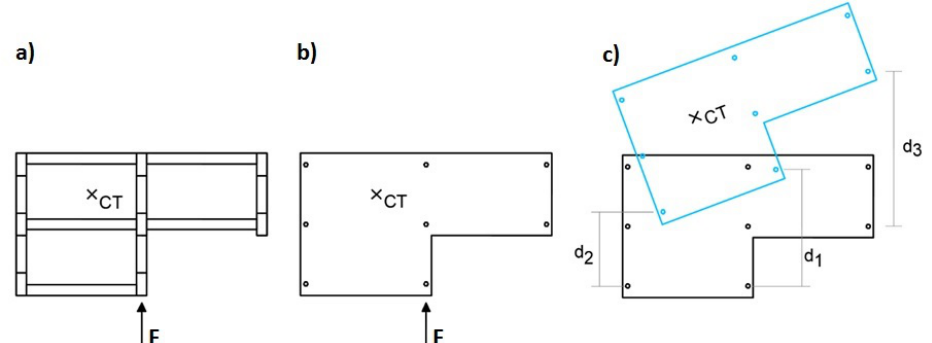
Figure 4. a) Force F at a building`s floor with center of twist CT. b) Simplification of the building`s floor. c) Structural elements presenting different